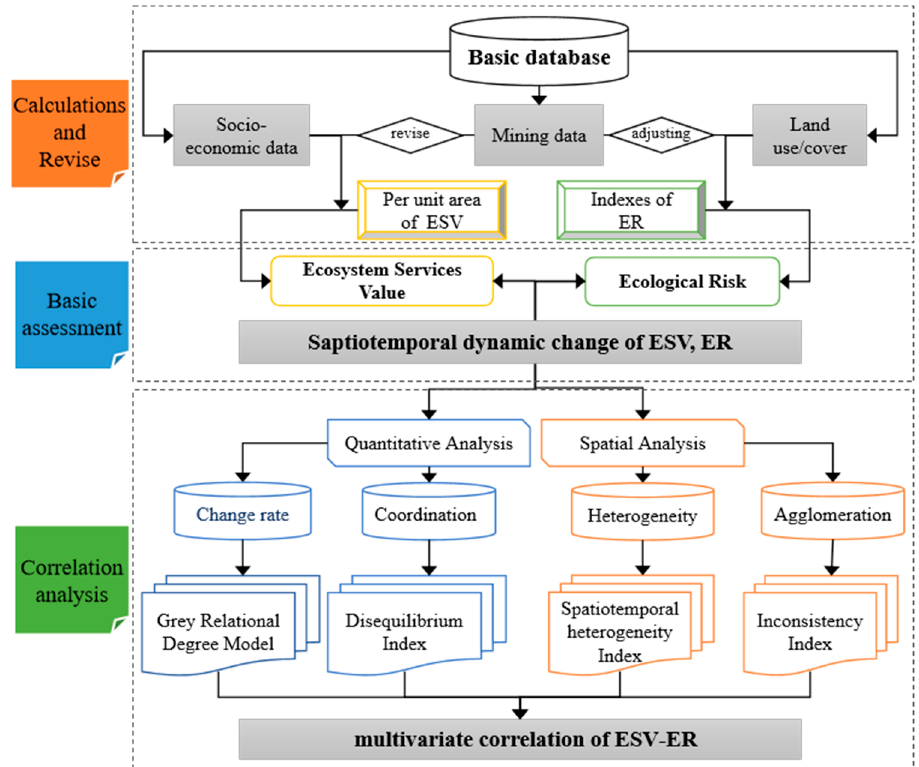
Figure 2. The research framework.